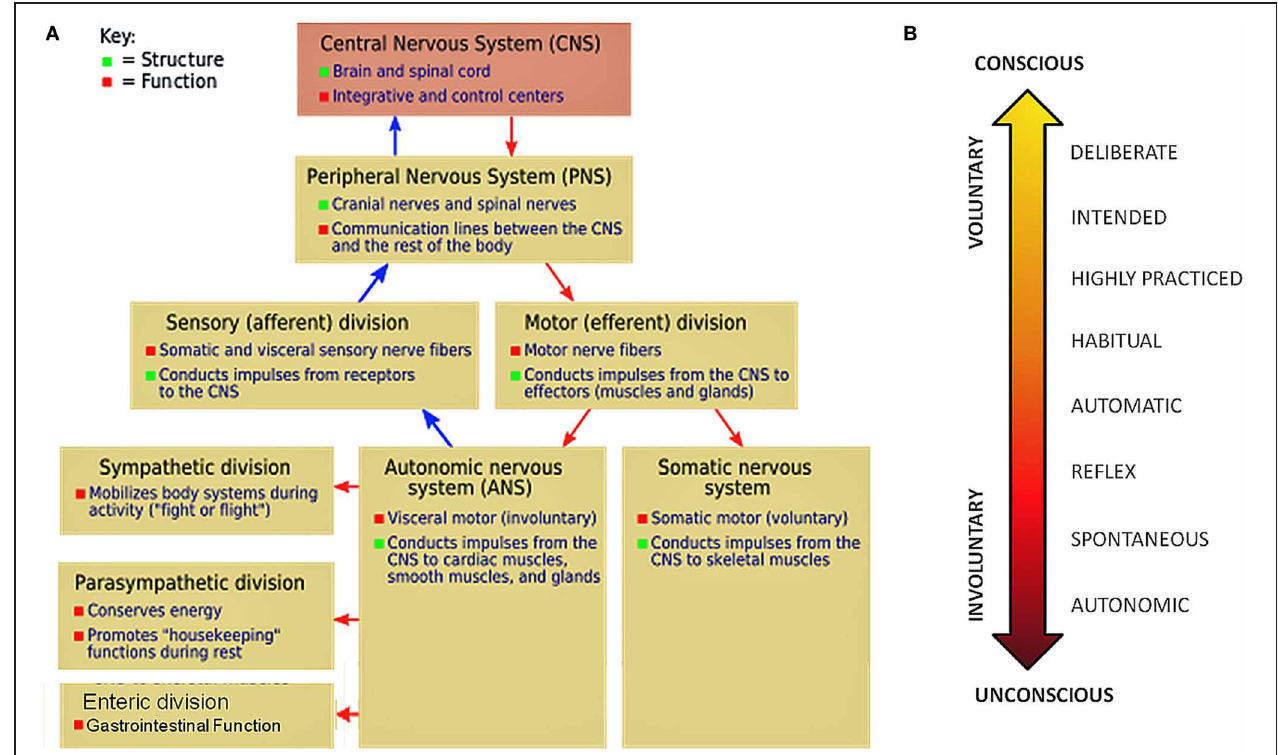
FIGURE 1 | Levels of the nervous system impacted by sensory-motor noise and gradient of movement variability mapped onto spectrum of movement functionality. (A) The labels of the simplified schematics represent only some of the many known functionalities of the system. Current autism research primarily focuses on centrally driven goal-oriented tasks typically performed under voluntary control and ignores the dynamics of the peripheral nervous systems (with their autonomic and somatic subdivisions). (B)